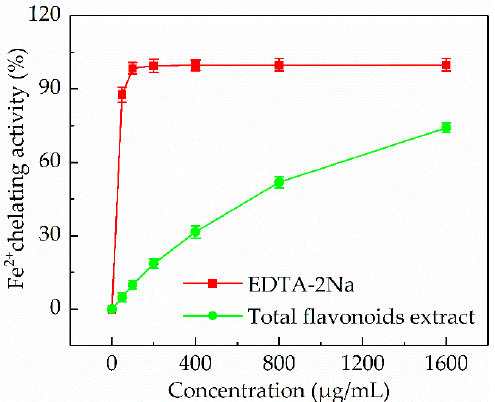
Figure 7. Fe 2 + chelating activity of the P. cretica extract obtained by optimized ultrasound-assisted compared with EDTA-2Na.